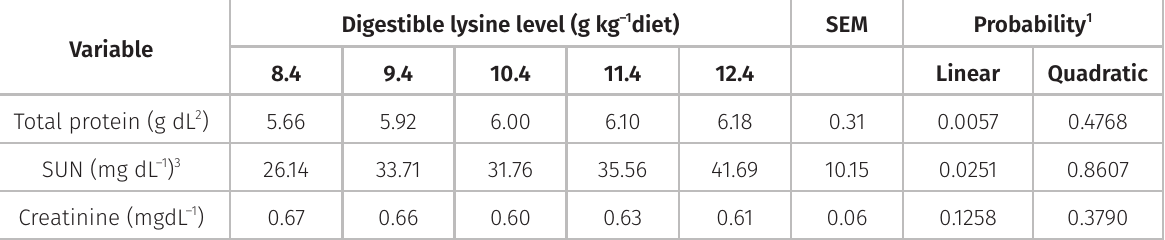
Table IV. Effect of digestible lysine level on blood parameters of barrows in the starter phase (15 to 30 kg).